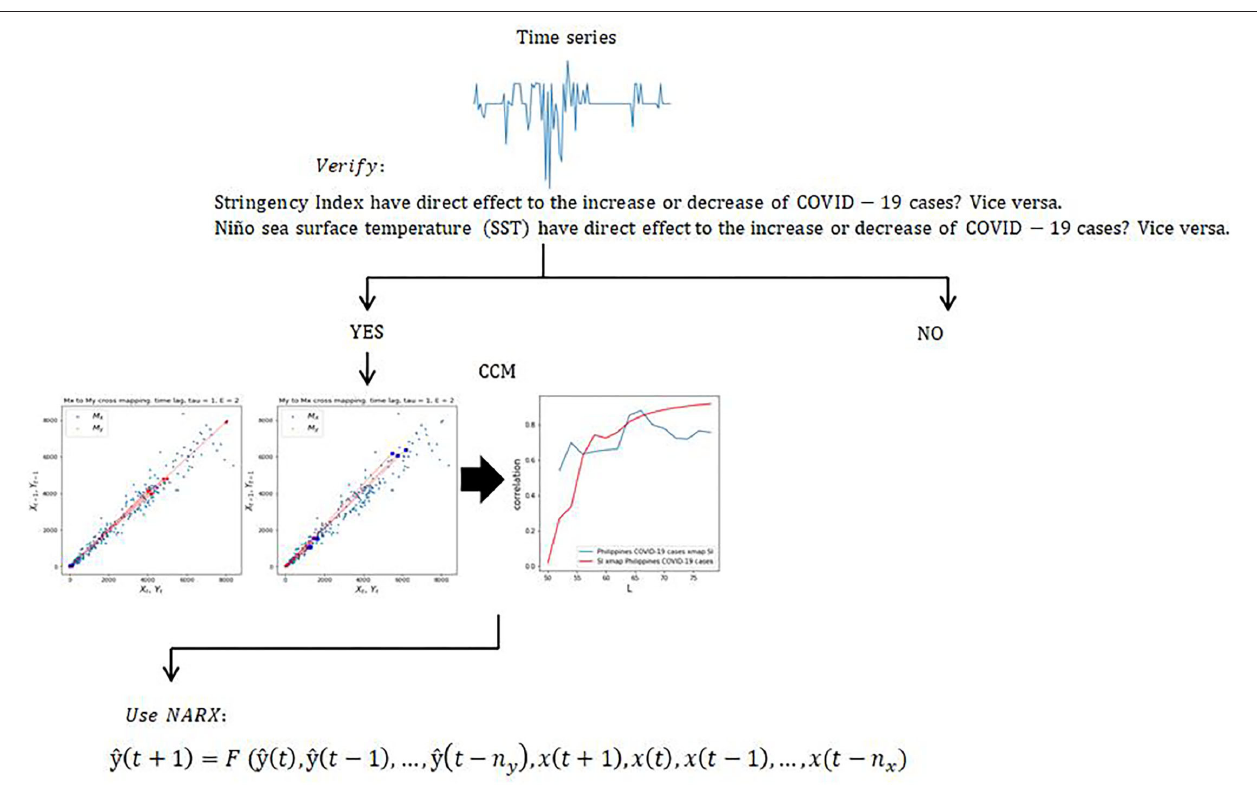
FIGURE 3 | Schematic diagram of the